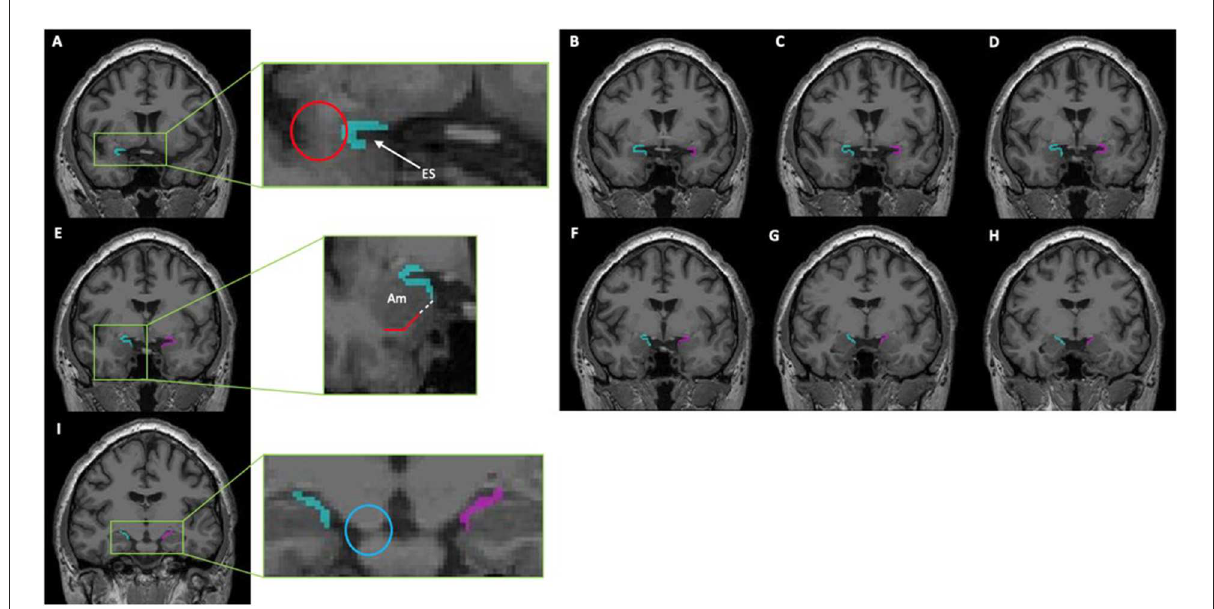
FIGURE1 This series of coronal T1-weighted MR-images depicts a segmentation of the piriform cortex using ITK-SNAP (Version 3.8.0). From rostral to caudal, the piriform cortex can be identified as follows: (A,B) The most rostral portion of the piriform cortex is denoted by the presence of the limen insulae (Red Circle); here it will consist of both a frontal- and temporal-component that creates a “C” shape around the entorhinal sulcus (ES). (C–E) The temporal portion of the piriform cortex is progressively extended until reaching the gyrus semiannularis. If the gyrus semiannularis was not easily identified, then a parallel line (white dotted line) extending from the white matter (red solid line) under the amygdala (Am) was made toward the surface of the cortex, and the temporal piriform was extended to that point. (F–H) As the optic tracts move laterally and merges with the temporal cortex, the frontal component of the piriform cortex recedes correspondingly. (I) Only the temporal piriform cortex can be seen; the most caudal portion of the piriform cortex is seen on the the coronal slice just before the cerebellar peduncle completely merges with the pons (Blue Circle). This protocol was adapted from those previously described by Goncalves Pereira et al. (7), Galovic et al. (5), and Iqbal et al.